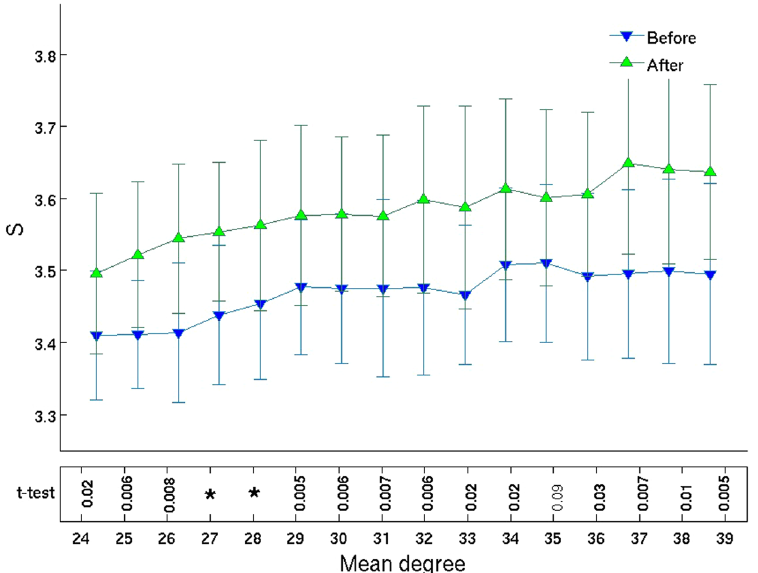
Figure 3. Entropy grows after Ayahuasca ingestion. Mean ± 1 standard deviation of the Shannon entropy of the distribution of node degrees, calculated over all 7 subjects, as a function of mean degree k , before (blue ∇ ) and after (green Δ ) Ayahuasca intake. The bottom row lists p -values for Student’s paired t -test, with values p < 0.005 indicated by asterisks ( * ). (Confidence intervals are shown in Supplementary Figure S5). We thus see evidence against the null hypothesis of no change in entropy. Indeed, we find a significant increase in the entropy of the degree distributions after Ayahuasca ingestion. This entropy increase is the main result that we